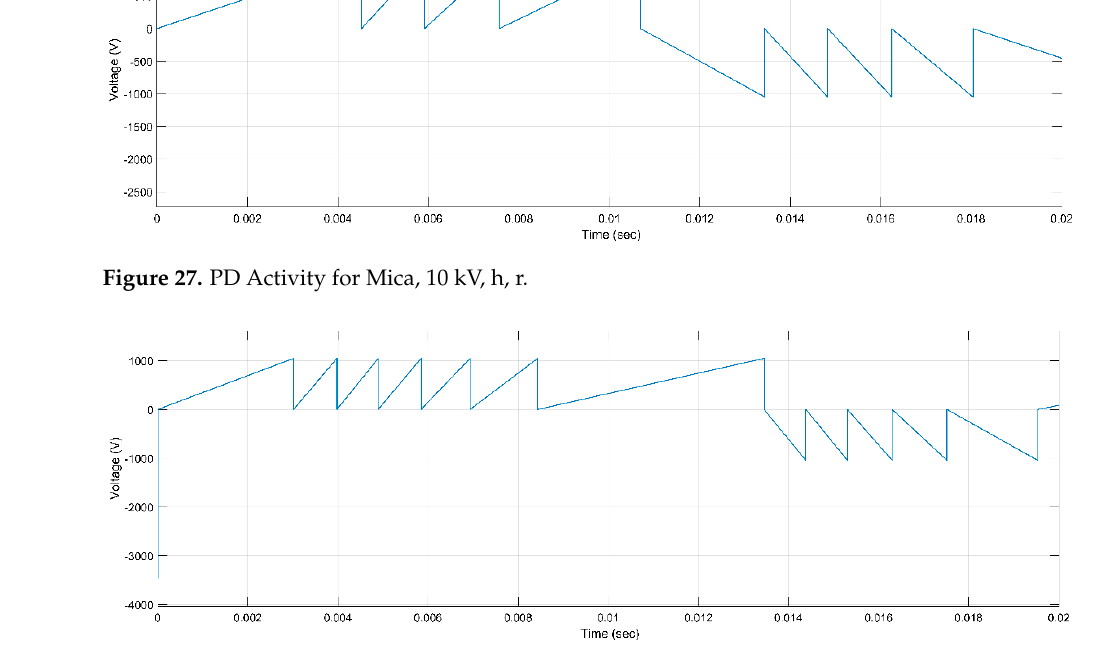
Figure 28. PD Activity for Mica, 15 kV, h, r.